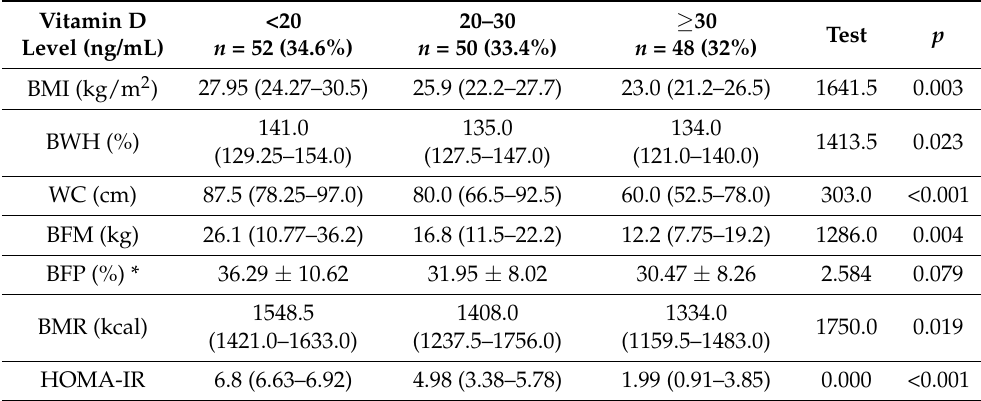
Table 3. Comparison of HOMA-IR scores and anthropometric measurements of individuals with respect to vitamin D levels.